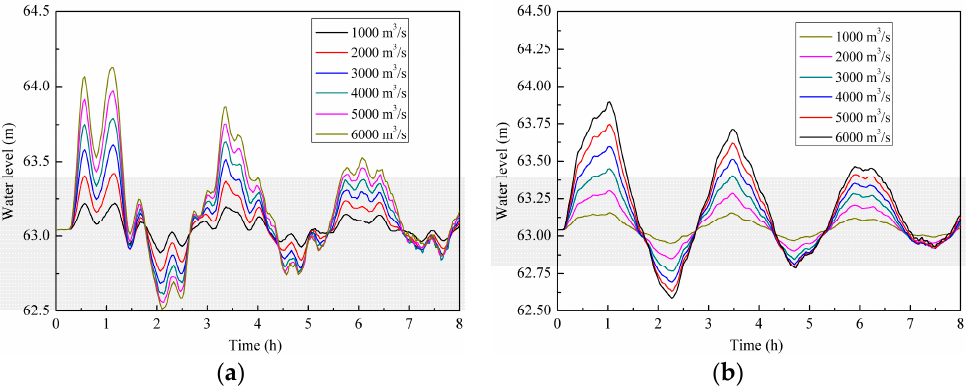
Figure 9. Water level variation process with flow variation amplitude. ( a ) Lower lock head of the ship lift; ( b ) Approach channel entrance.